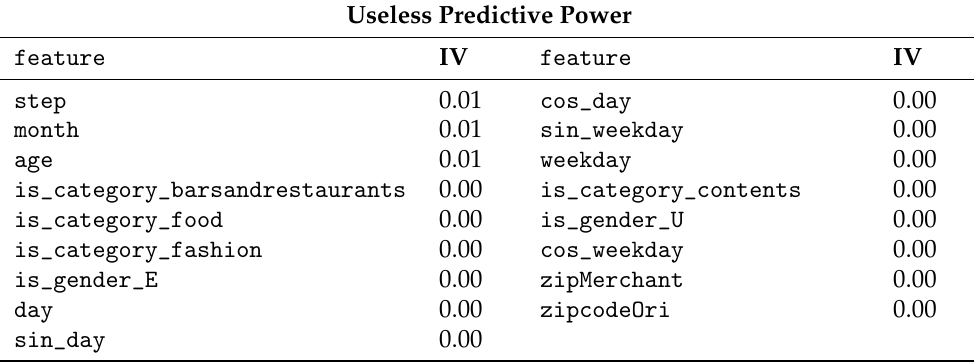
Table 19. Extended BankSim dataset information value—Part 2.